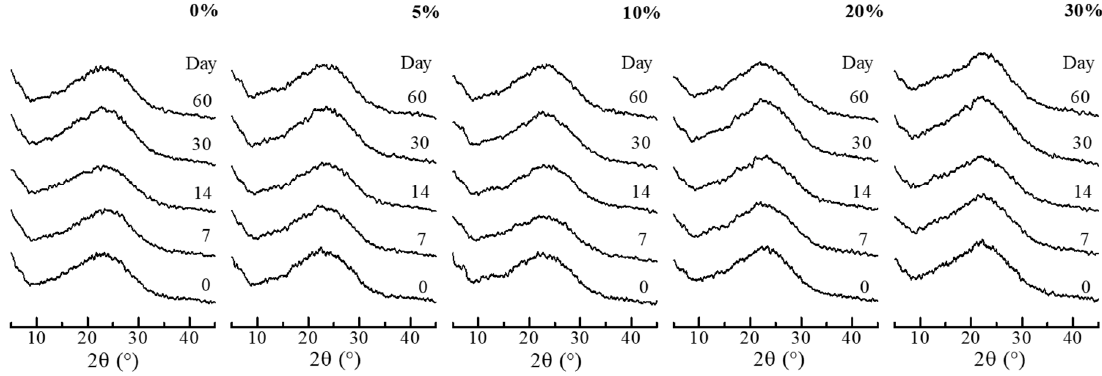
Figure 4. XRD patterns of SGR granules after storage at 20 °C/30% RH. Percentages indicate the weight percentage of PVP-VA in the granules.